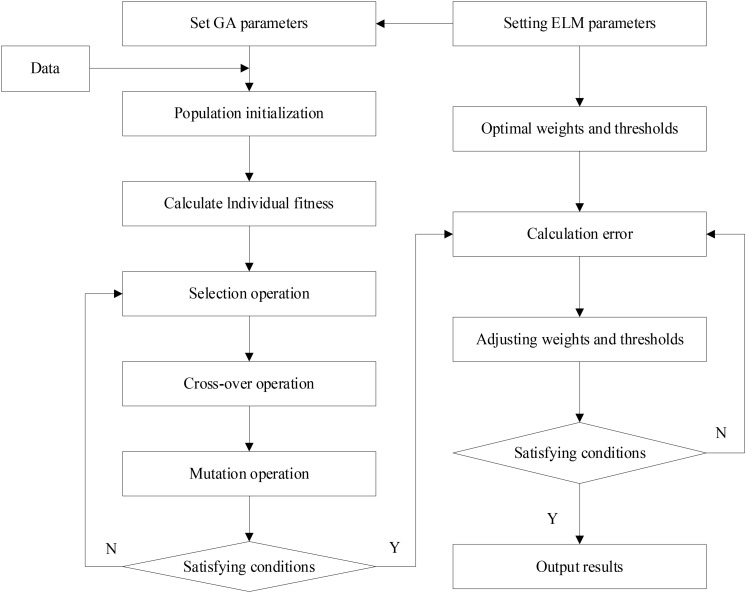
Flow chart optimization of ELM based on GA.